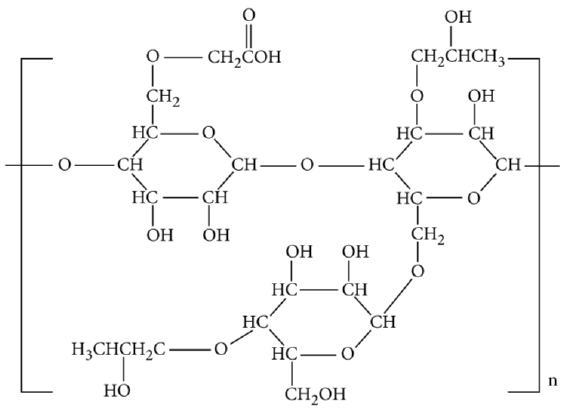
Figure 4. Molecular structure of CMHPG [41].